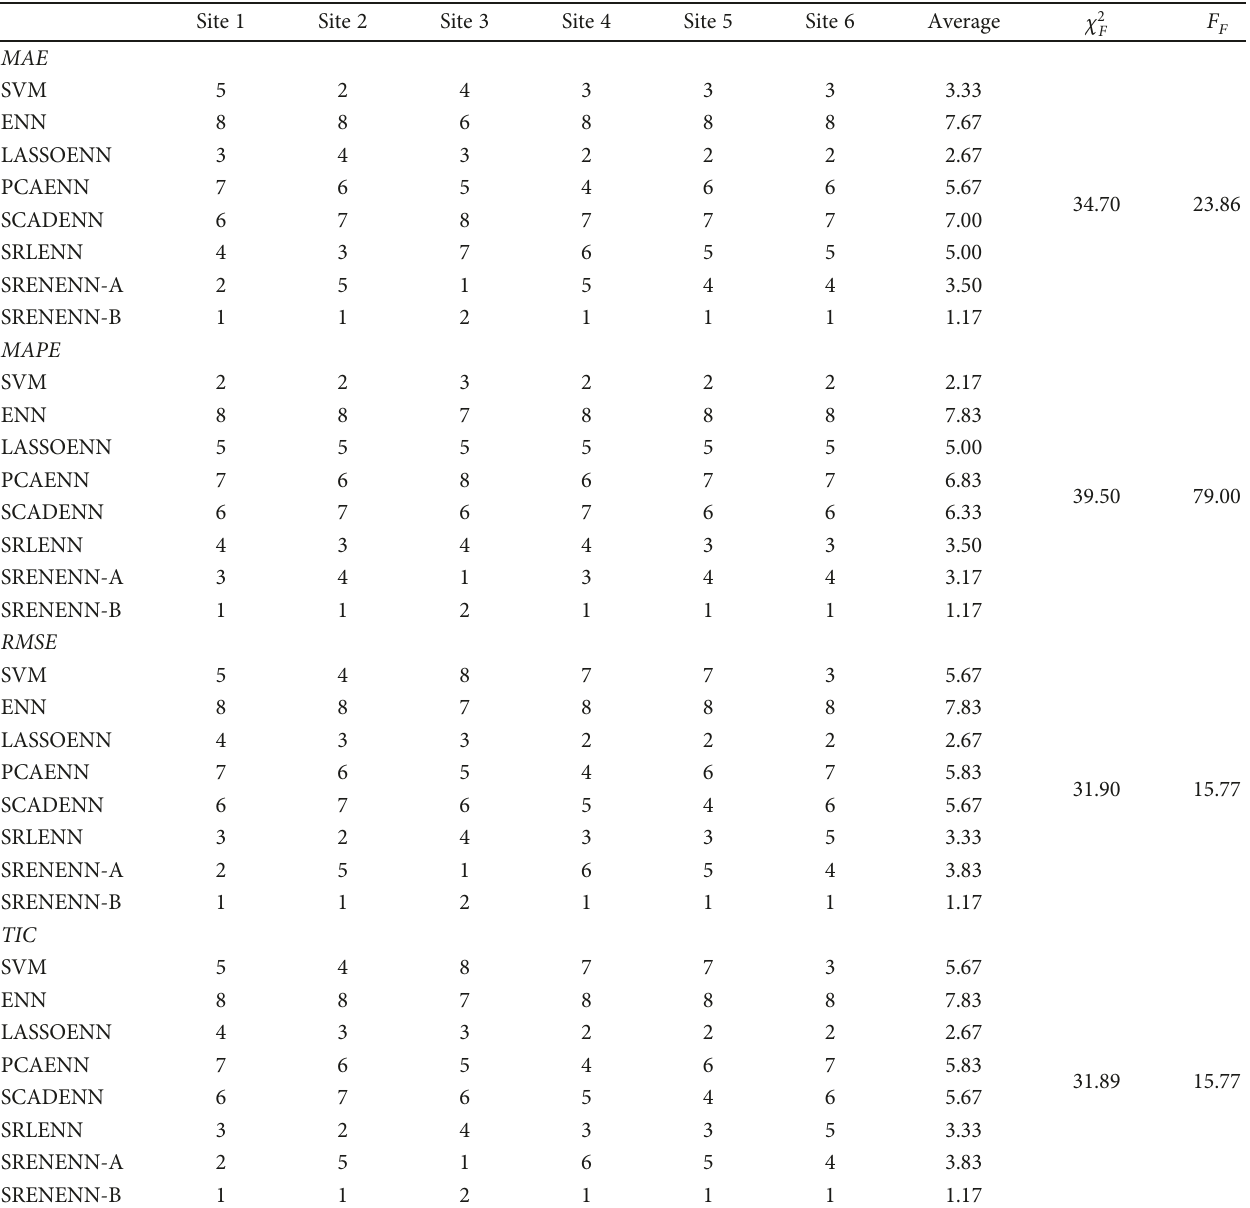
Table 9: The results based on Friedman test for compared